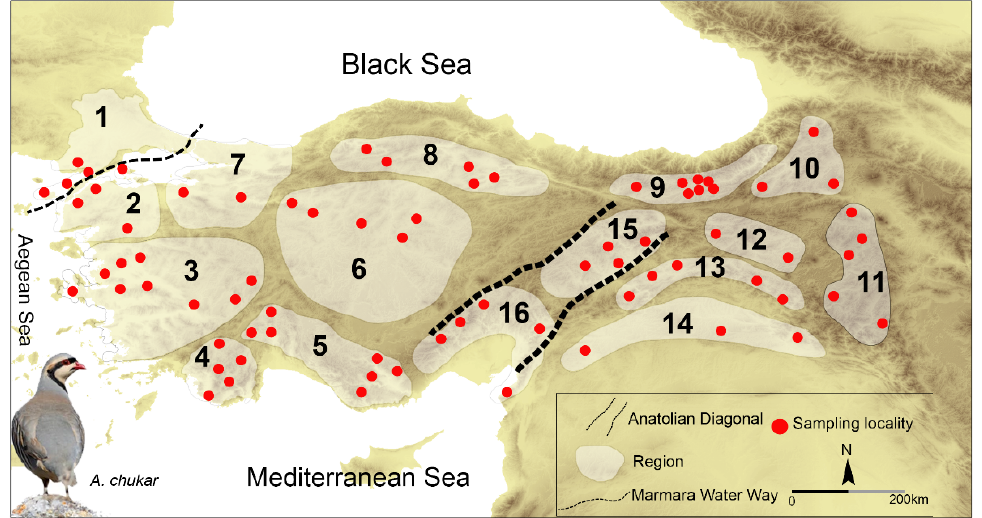
Figure 1. Sampling areas of A. chukar in Türkiye.